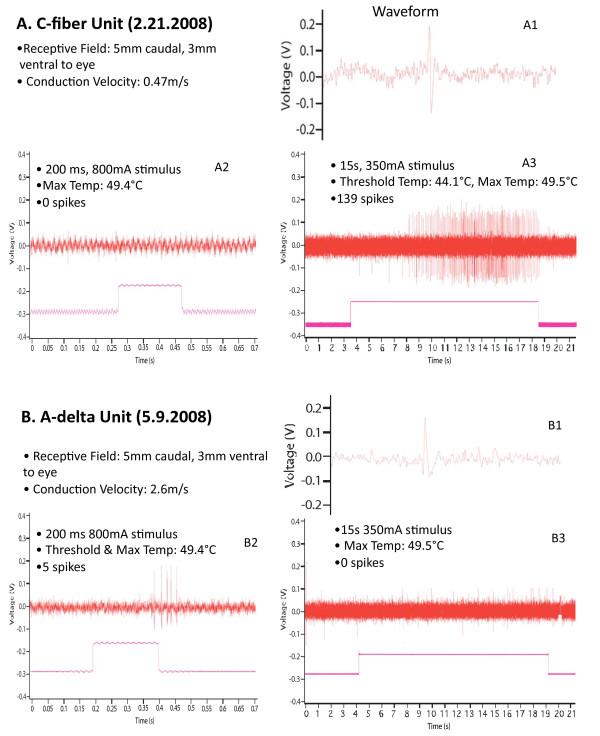
Examples of responses of individual C fiber and A-delta nociceptor units to long or short laser pulses. A. Response of a C fiber nociceptor, A1 - action potential shape; A2 - lack of response to short pulse; A3 - response to long pulse; B. Response of an A-delta nociceptor, B1 - action potential shape; B2 - response to short pulse; B3 - lack of response to long pulse.